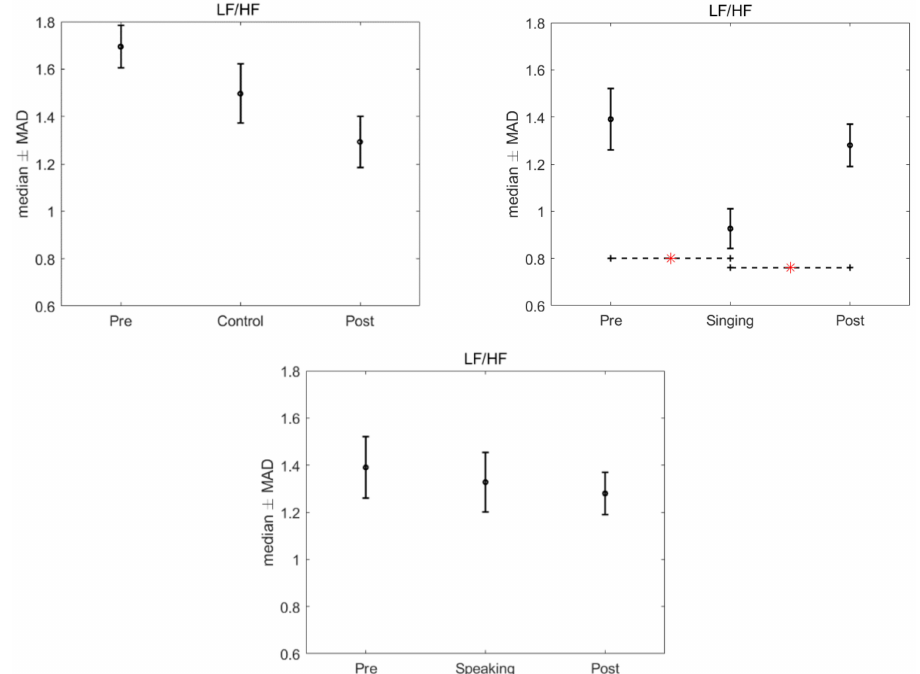
Figure 4. Median and MAD of LF/HF for the three time conditions related to the control, singing and speaking groups. The asterisk indicates the significant comparisons observed after we used Bonferroni’s test for post hoc